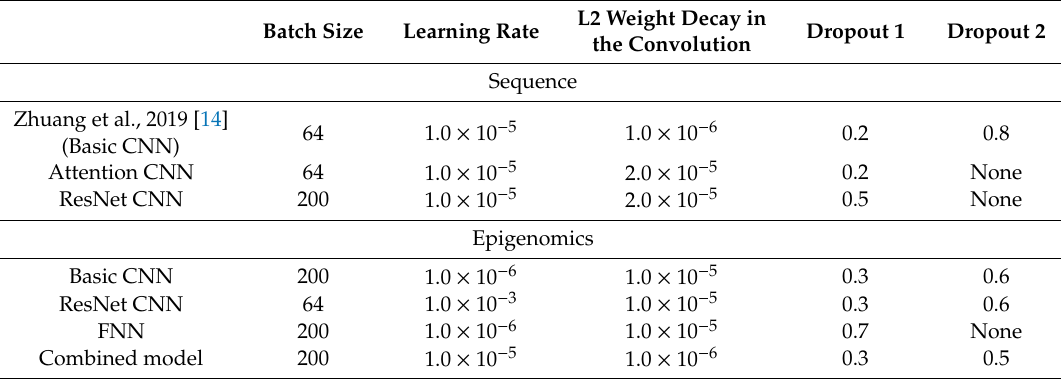
Table 1. Parameters for convolutional neural network (CNN) models.